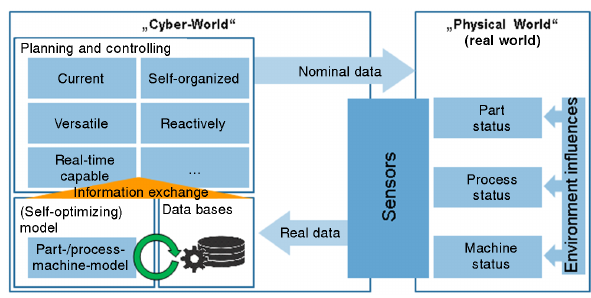
Figure 1. Definition: the cyber-physical system (Schmitt et al., 2014).